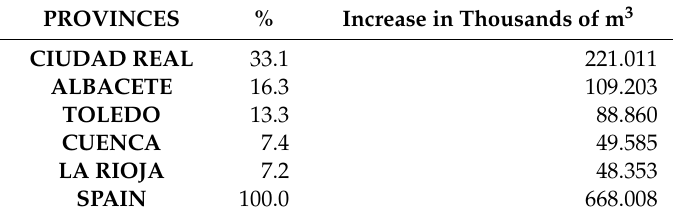
Table 4. Contribution to the change of the blue water footprint of wine from 1950 to 2013 of the five top Spanish